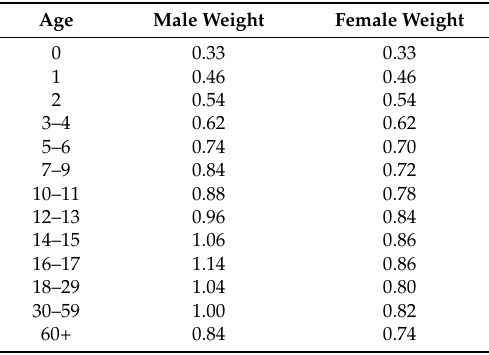
Table A1. Adult equivalence